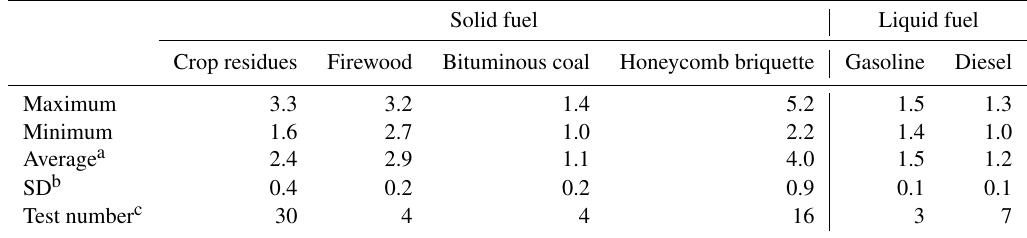
Table 1. Summary of the aerosol absorption Ångström exponent (AAE) obtained from source